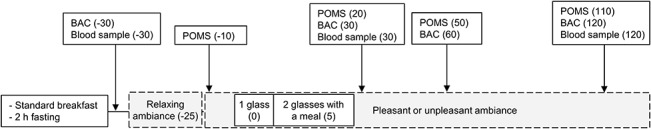
Overview of the experimental procedures during a study day.Time points are indicated within parentheses. BAC, Blood alcohol concentration; POMS, Profile of Mood States questionnaire.